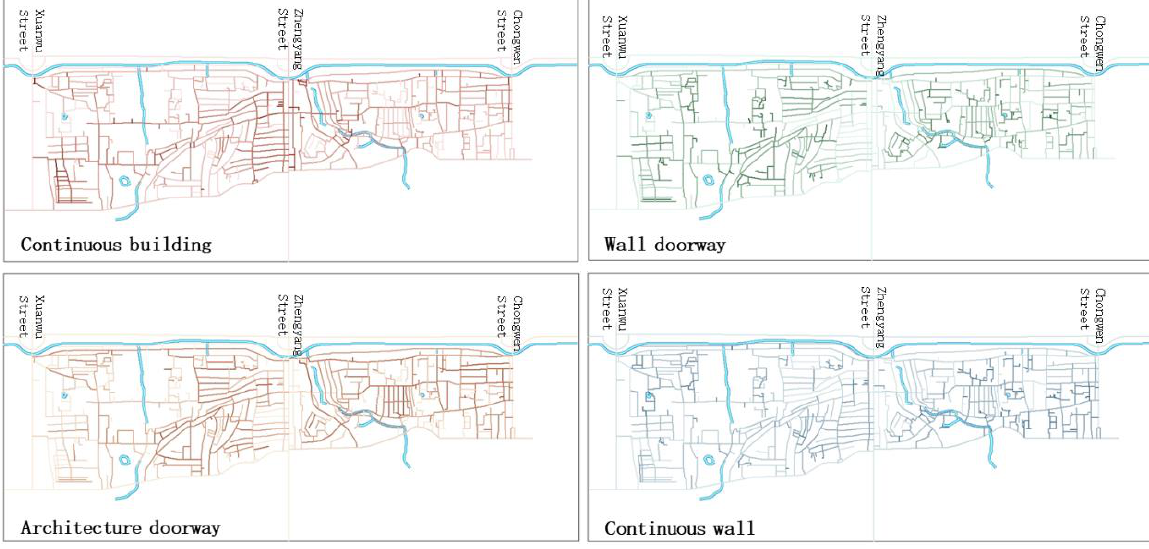
Figure 13. Analysis of four types of building form per unit road